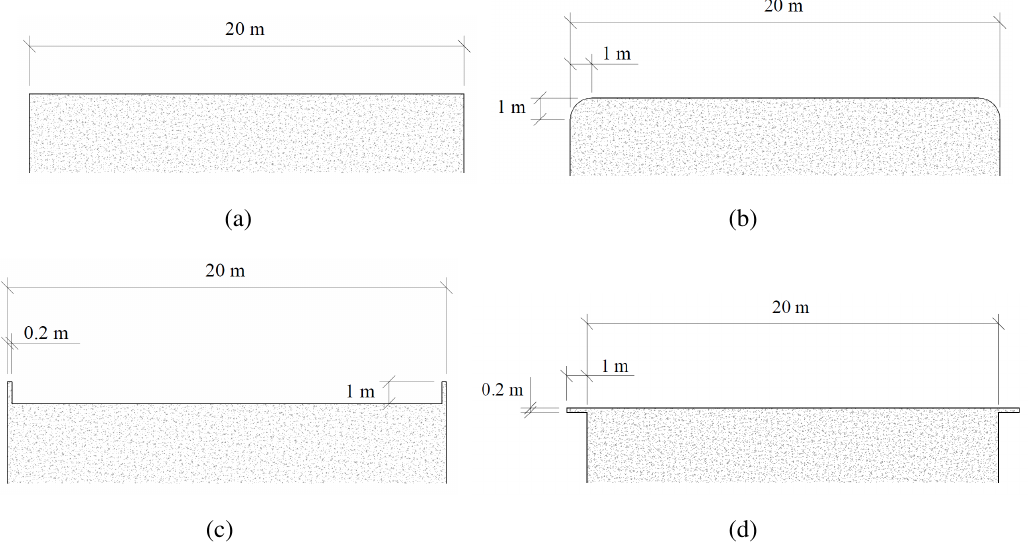
Figure 15. Central vertical section detail of the different roof edge shapes investigated. ( a ) Simple edge; ( b ) curved edge; ( c ) railing; ( d )